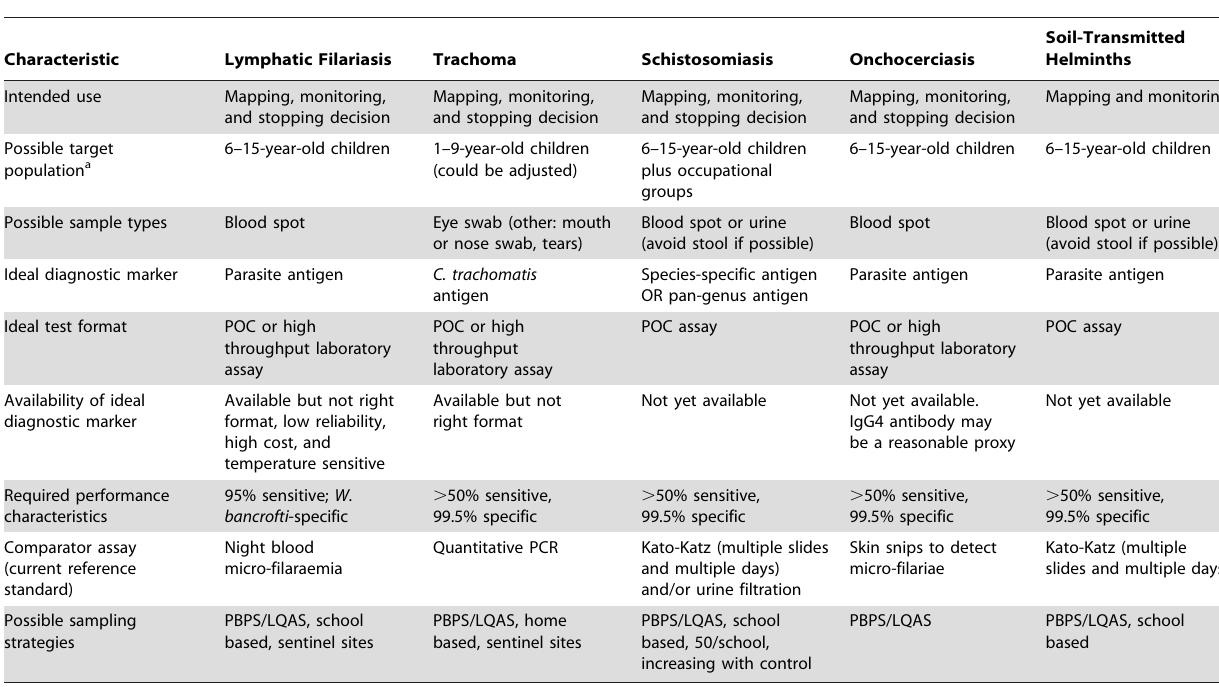
Table 1. Proposed target product profiles for diagnostic tools for selected NTDs, mapping, and impact